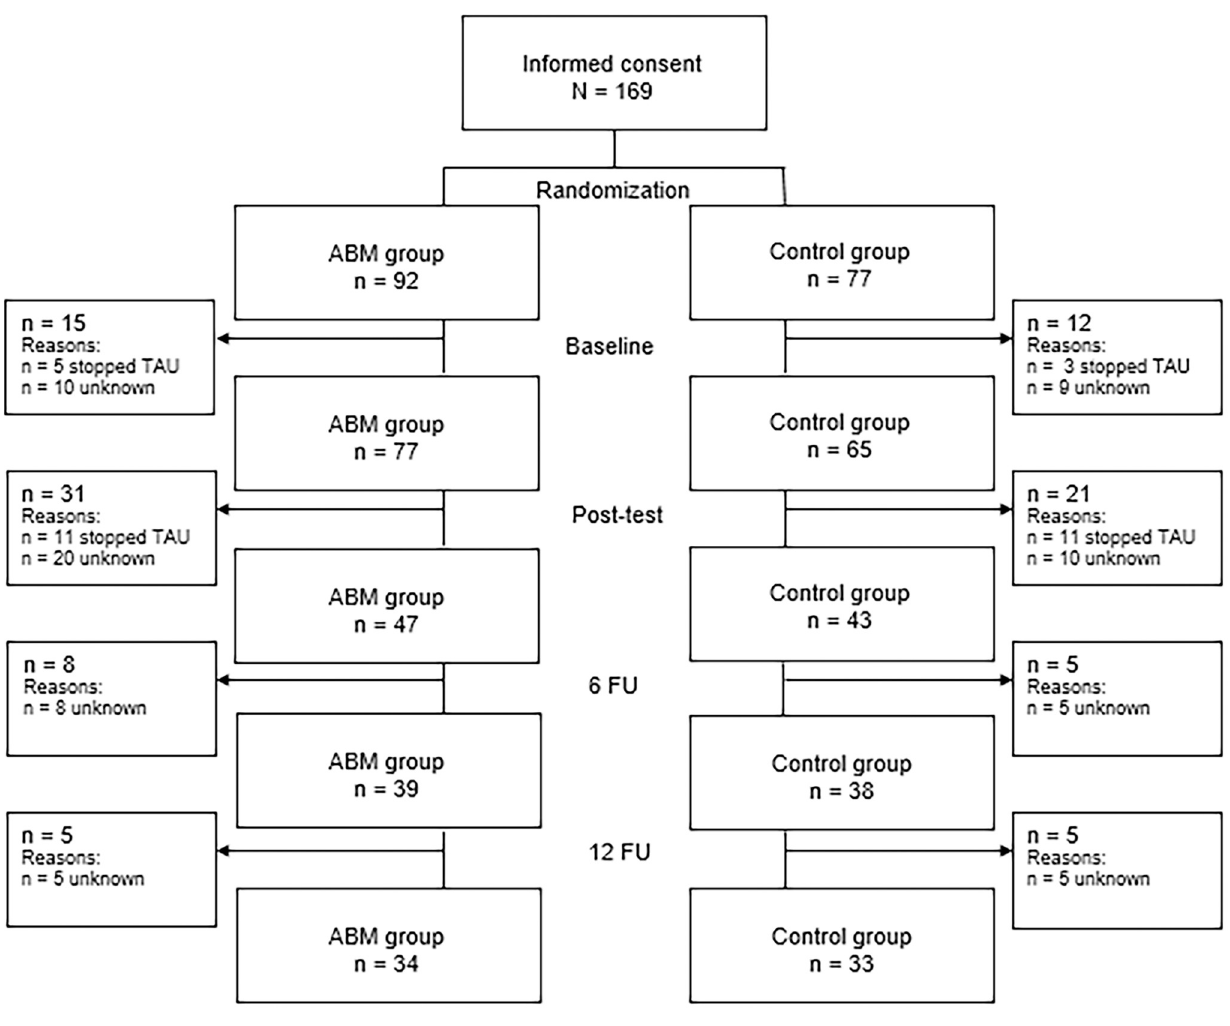
Fig 1. Participants